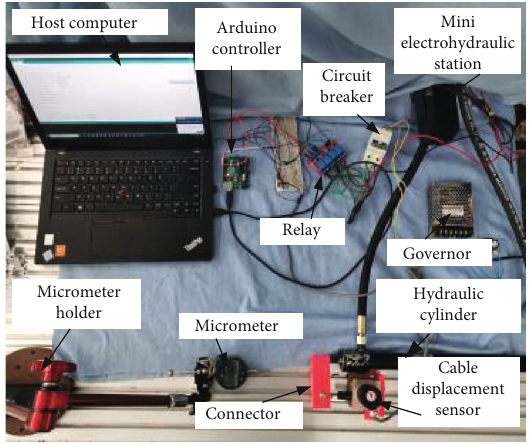
Figure 13: System wiring